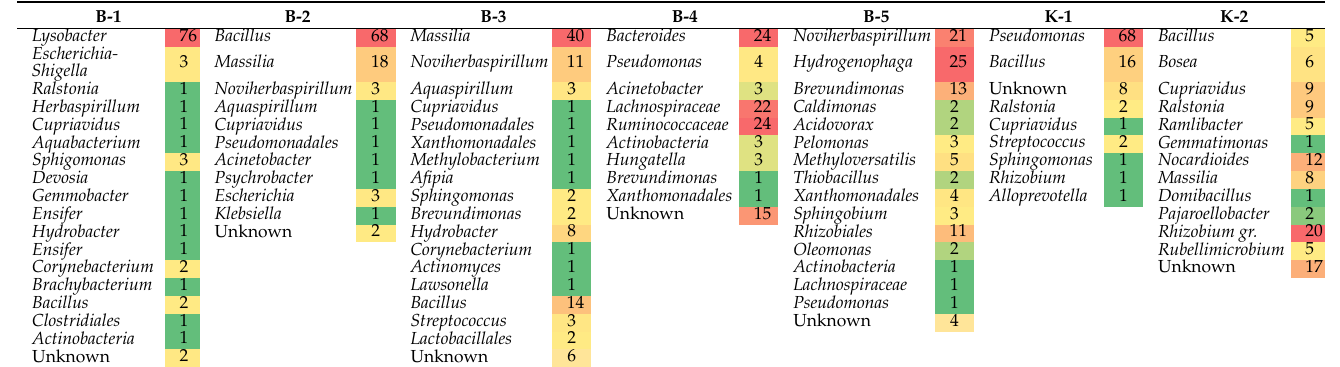
Table 5. Phylogenetic diversity of microbial communities in clay samples before